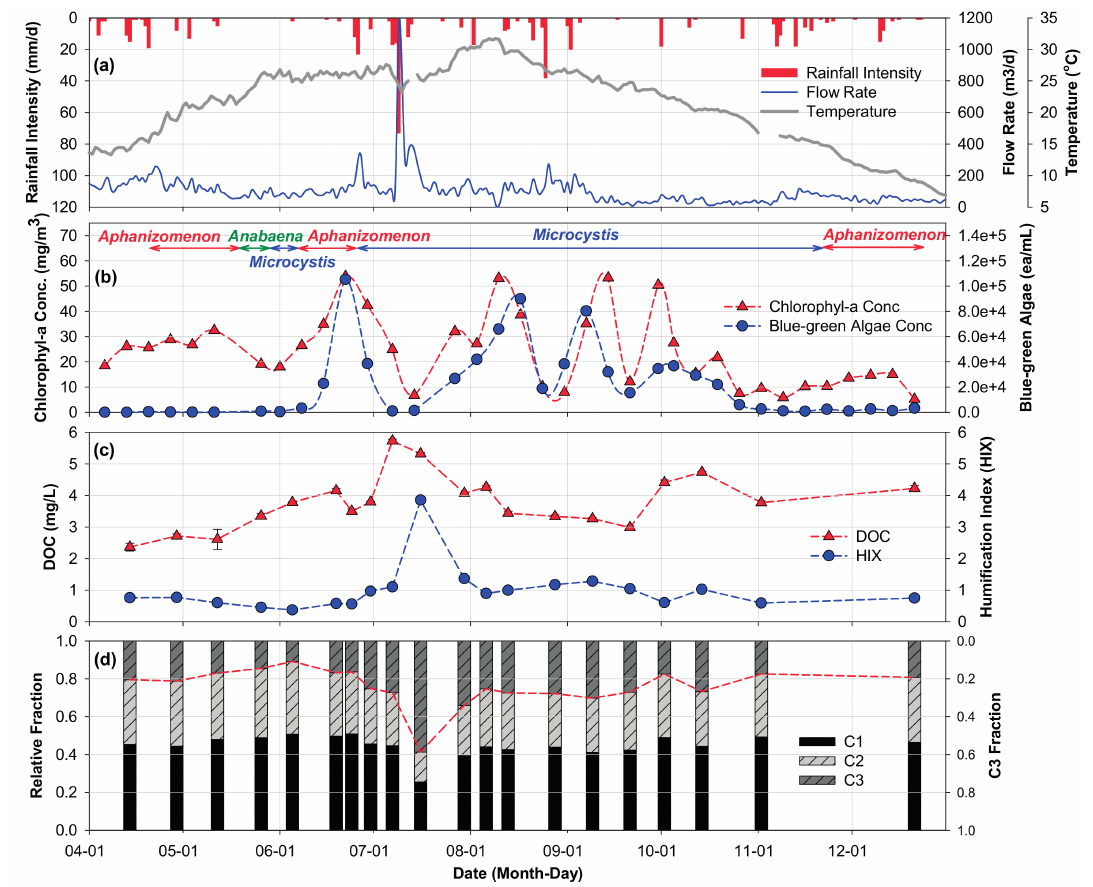
Figure 3. Seasonal variation in the physical and biogeochemical indicators of ( a ) rainfall intensity, flow rate, and temperature; ( b ) chlorophyll-a concentration and blue-green algae concentration; ( c ) dissolved organic carbon (DOC); and ( d ) relative fractions of the organic matter